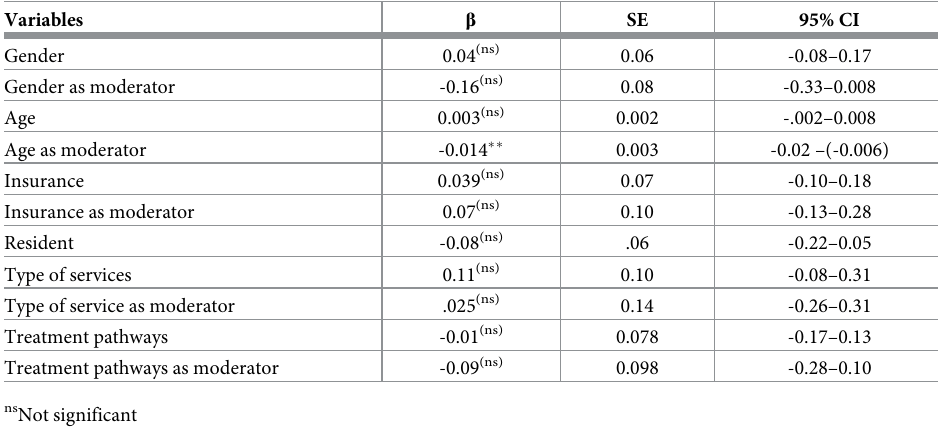
Table 6. Moderating effects of demographic characteristics and treatment pathways on the